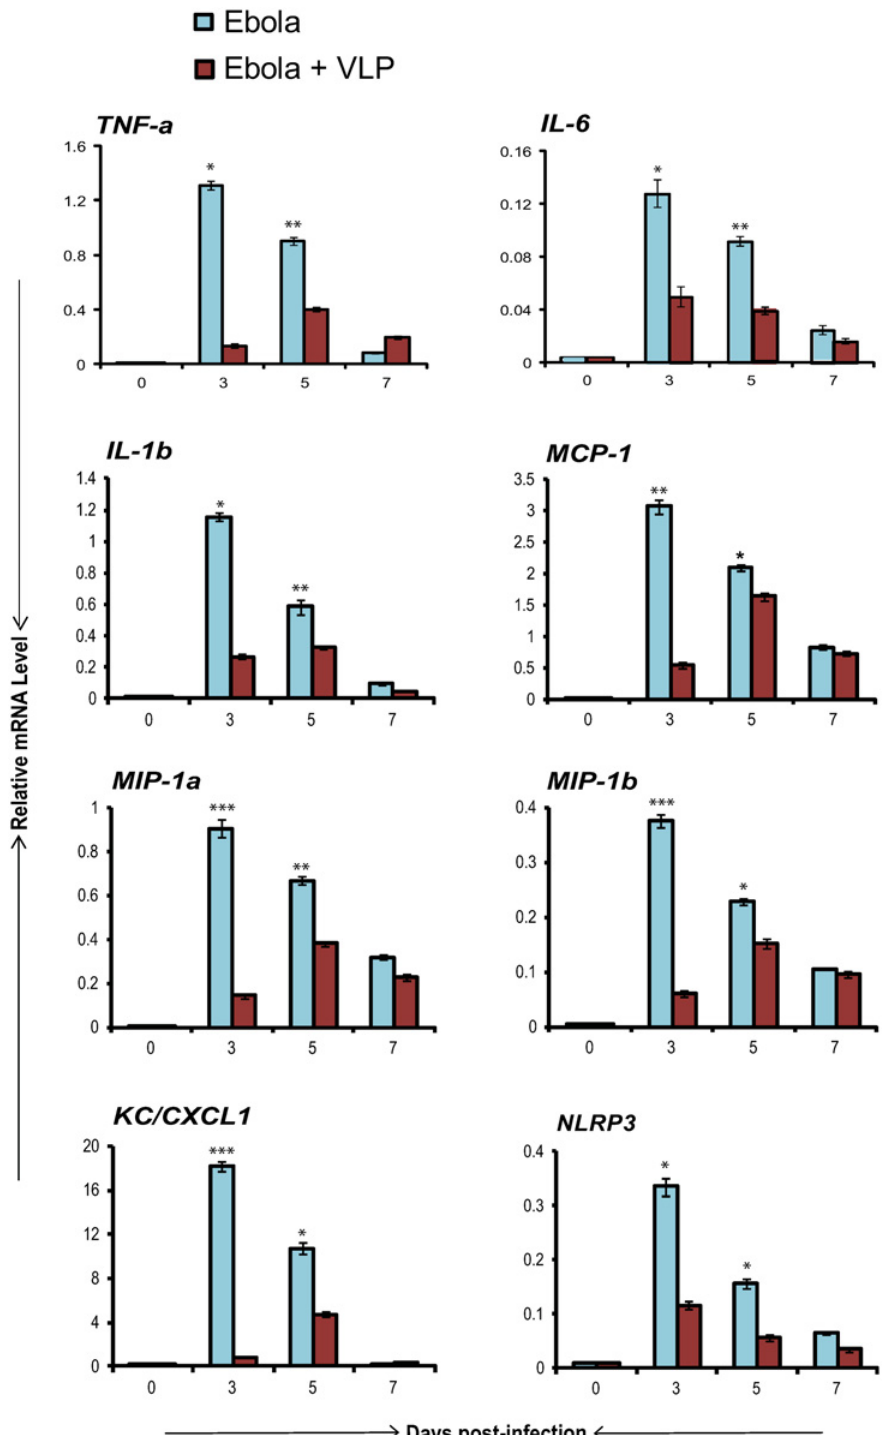
Fig 3. VLPs attenuate proinflammatory cytokine induction in EBOV infected mice. RNA from liver of WT mice (n = 5/group) infected with EBOV with or without VLP treatment was tested for expression of proinflammatory cytokines (TNF α , IL-6 and IL-1 β ), chemokines (MCP-1, MIP-1 α , MIP-1 β and KC (CXCL1)) and Inflammasome gene NLRP3 on indicated days post-infection. Values represent the average of duplicate samples from three independent experiments ± SEM. * p (cid:1) 0.05, ** p (cid:1) 0.01, *** p (cid:1) 0.001 indicates statistical significance.